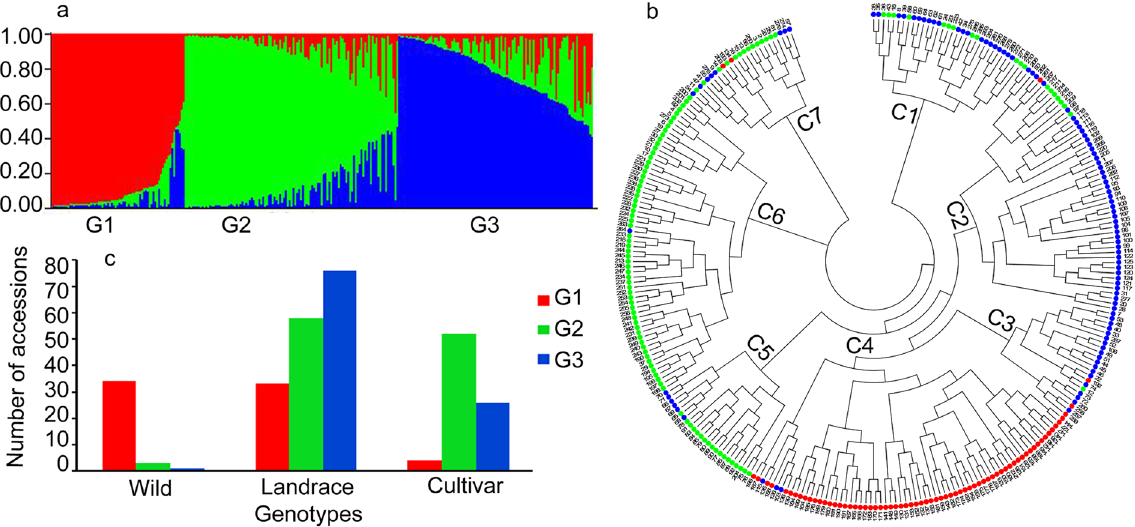
Figure 2. Genetic diversity of the 287 barley germplasm. ( a ) Population structure of the population. G1–G3 stand for three groups. The y-axis is the subgroup membership, and the x-axis is the accessions in three groups (G1, G2, and G3). ( b) Cluster tree based on UPGMA. C1–C7 stand for cluster 1 to 7. The UPGMA tree is color- coded based on the results from population structure analysis (red G1, green G2, and blue G3); ( c ) Number of accessions in each of the three groups from different